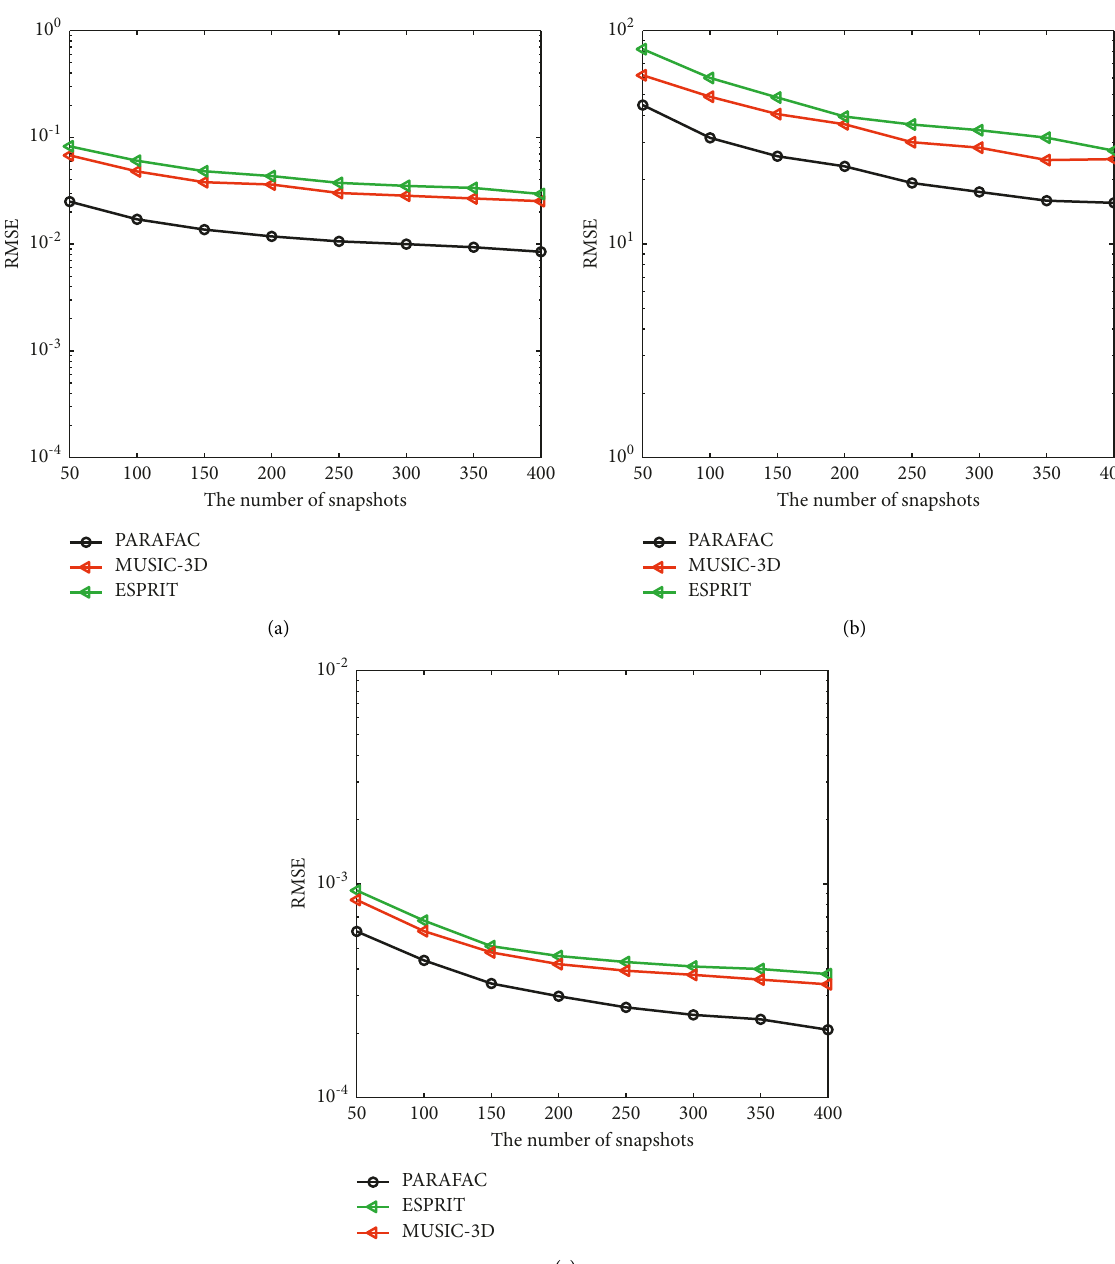
Figure 4: The RMSE versus the number of snapshots. (a) The angle, (b) the range, and (c) the